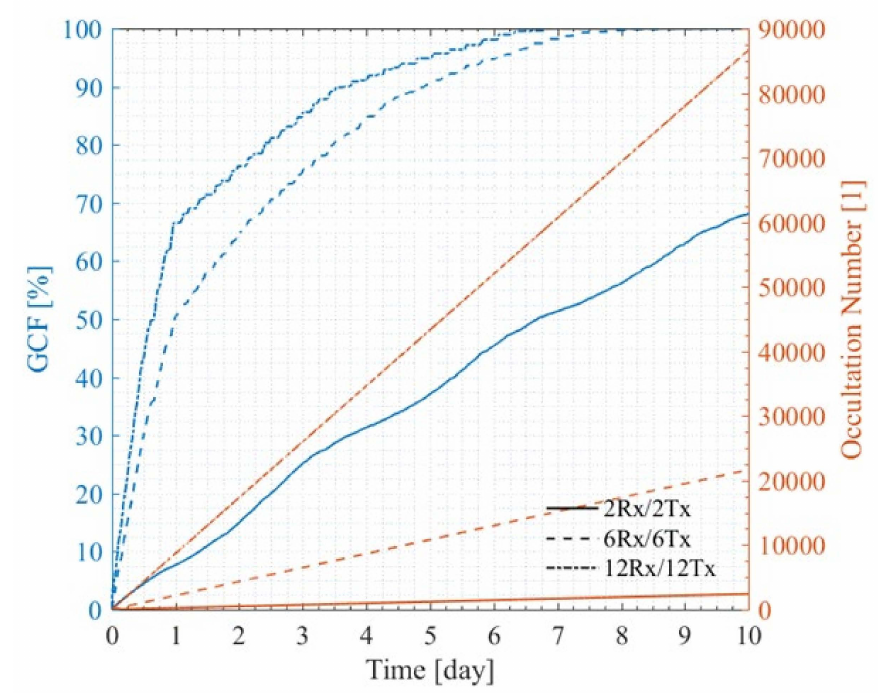
Figure 12. Accumulated time dependence of the global coverage fraction (GCF) (blue lines) and the occultation event number (orange lines) for the 2Rx/2Tx, 6Rx/6Tx, and 12Rx/12Tx constellations with the Rxi98 and Txi98 inclination orbital planes.